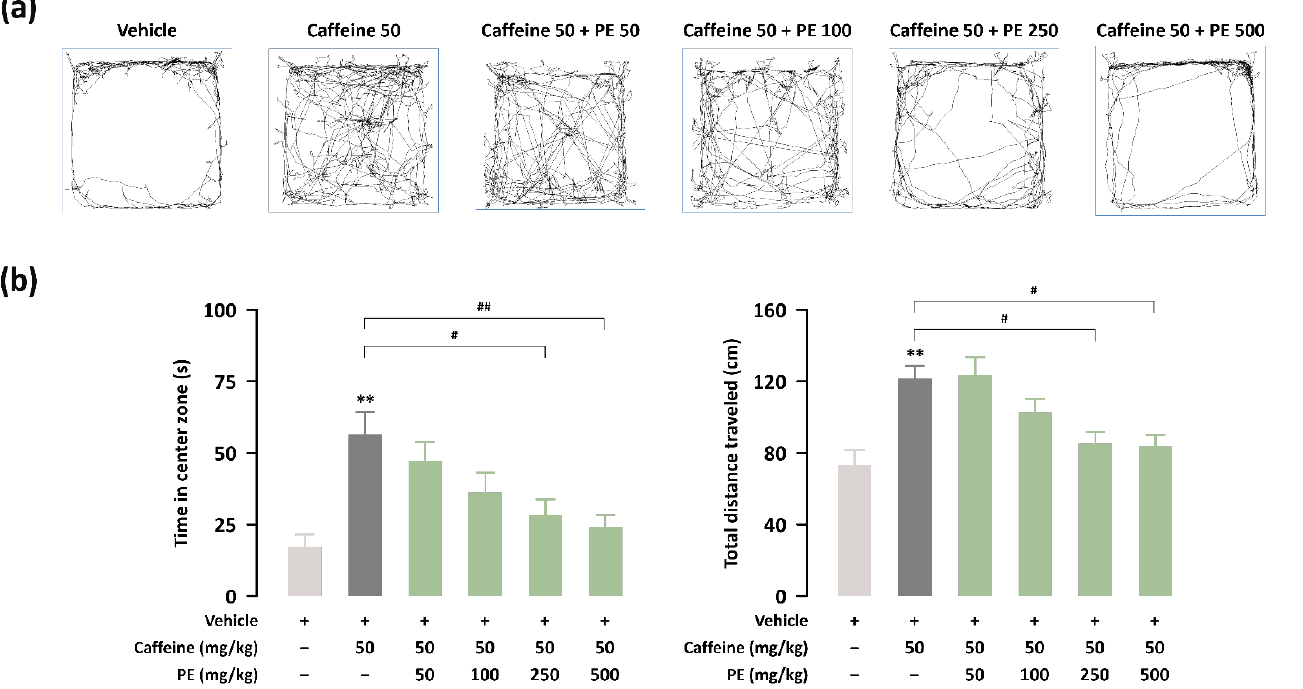
Figure 6. Effect of PE on the open field test (OFT) in caffeine-induced excitation. ( a ) Individual examples of locomotor activity. ( b ) Time in the center zone (s) and total distance traveled (cm) in the OFT ( n = 10 per group). Results are presented as mean ± SEM. ** p < 0.01, significant difference compared to the vehicle group (Tukey’s test). # p < 0.05, ## p < 0.01, significant difference compared to the caffeine-alone-treated group.